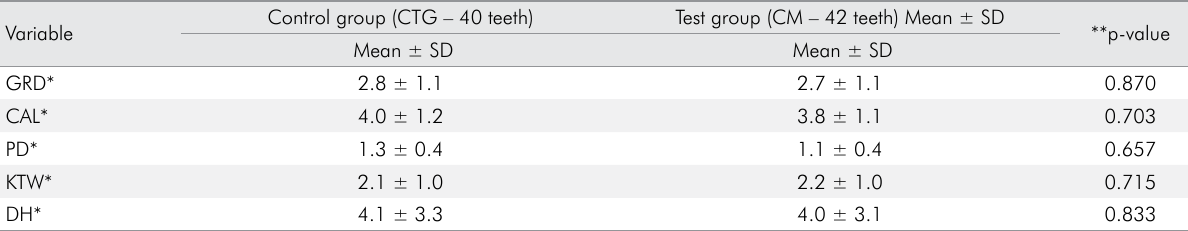
Table 1. Descriptive analysis of tooth-related variables and a comparison of the groups at